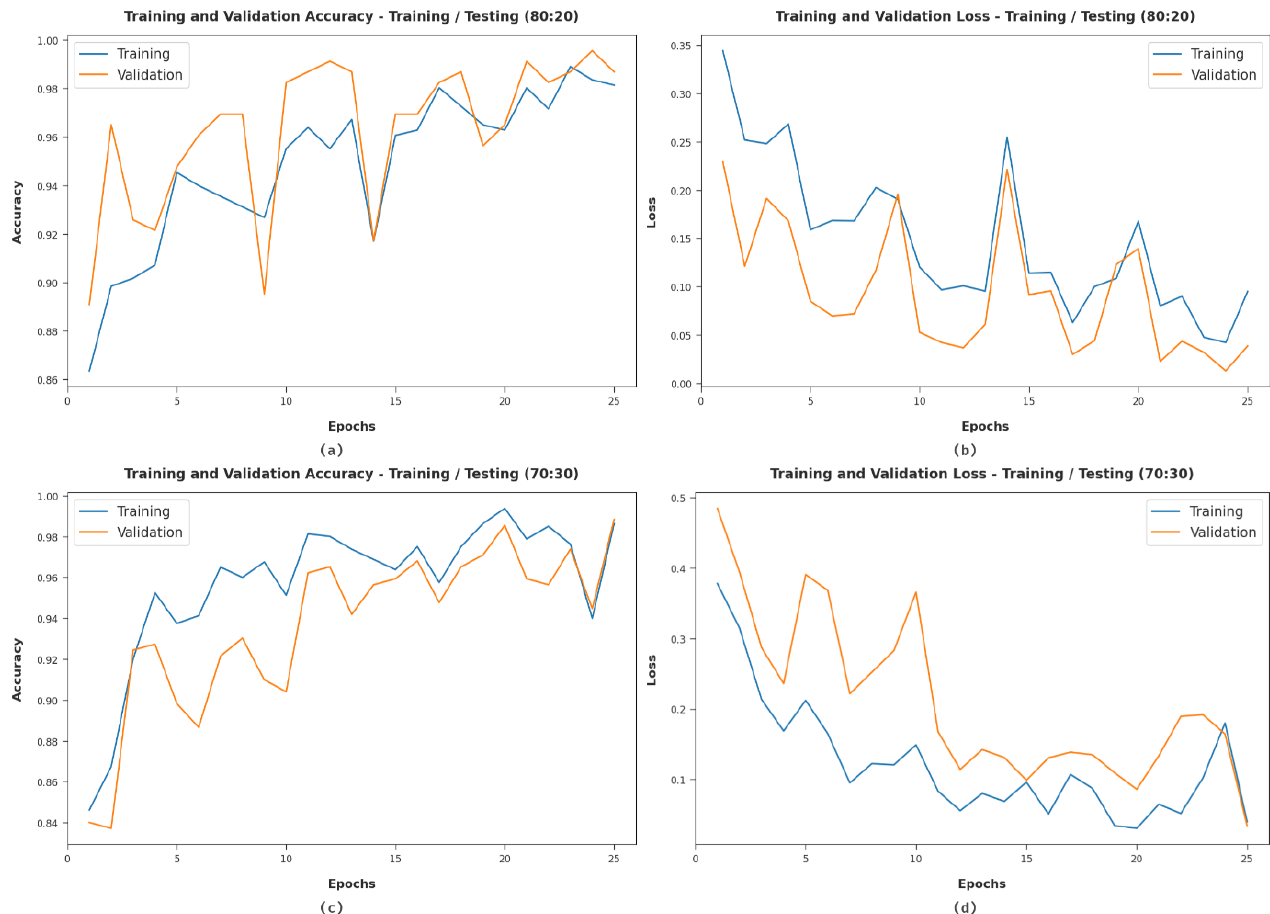
Figure 7. Classification analysis of WDODTL-ODC technique ( a ) 80:20 of accuracy, ( b ) 80:20 of loss, ( c ) 70:30 of accuracy, and ( d ) 70:30 of loss.